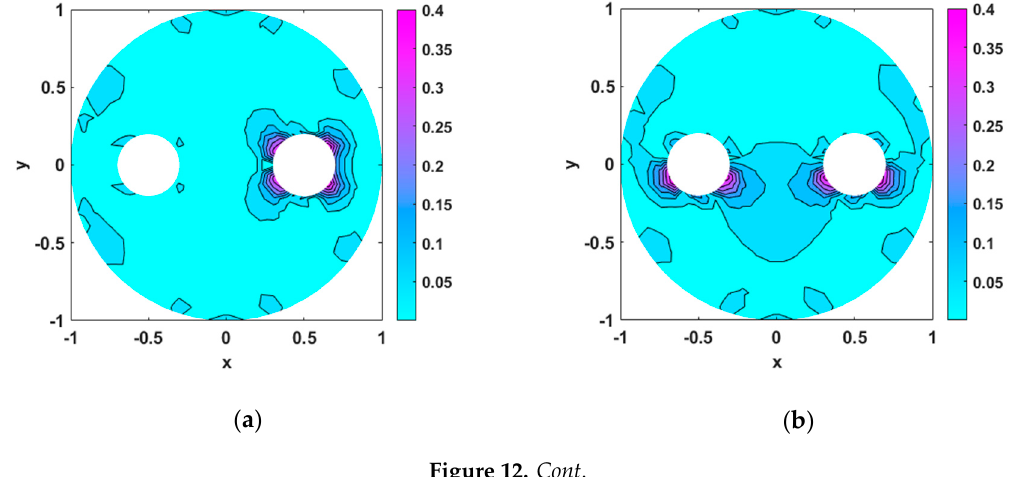
( d ) Figure 12. Contour plots of absolute errors (%): ( a ) half unknown inner boundary; ( b ) two half unknown inner boundaries; ( c ) unknown inner boundaries; ( d ) half unknown outer boundary.